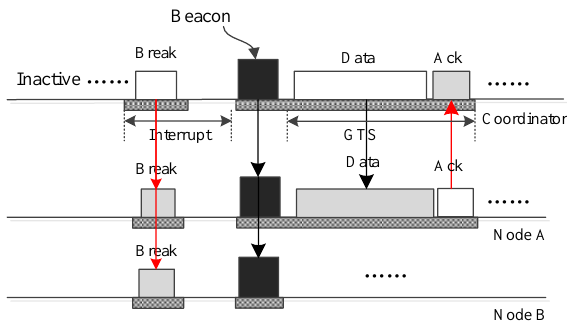
Figure 8. The coordinator sends big data to one node.